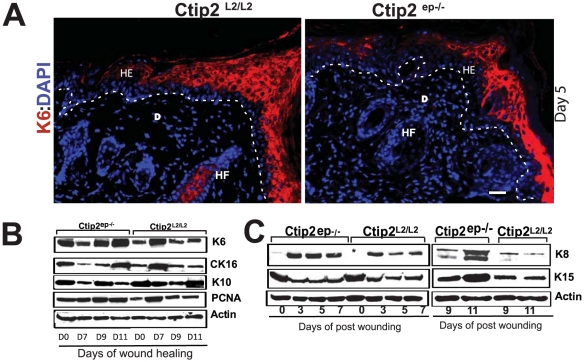
Altered keratinocyte activation (K6 & K16), proliferation (PCNA), differentiation (K10 & K8), and impaired expression of epithelial stem cell marker (K15) during wound healing in mutant mice.(A) IHC analysis of K6 (red) expression on Day 5 post wounding samples from Ctip2L2/L2 and Ctip2ep−/− mice. The white dotted lines indicate the migratory tongue on the wound bed (Day5 samples) and separation of the epidermis from dermis in (A). All sections were counterstained with DAPI (blue). HE- hyperproliferative epithelium; E- epidermis; D- dermis; HF- hair follicle. Scale bar: 50 µm. (B) Immunoblot analyses of PCNA, K10, K6 and K16 in adult skin of Ctip2L2/L2 and Ctip2ep−/− mice after wounding (Day 7, Day 9 and Day 11). (C) Immunoblot analyses of keratin markers, K8 and K15 induction in the skin of Ctip2L2/L2 and Ctip2ep−/− adult mice on days 3, 5, 7, 9 & 11 post wounding. * indicates undetectable K8 expression in the unwounded wild type skin (day 0). β-actin is used as an internal control.